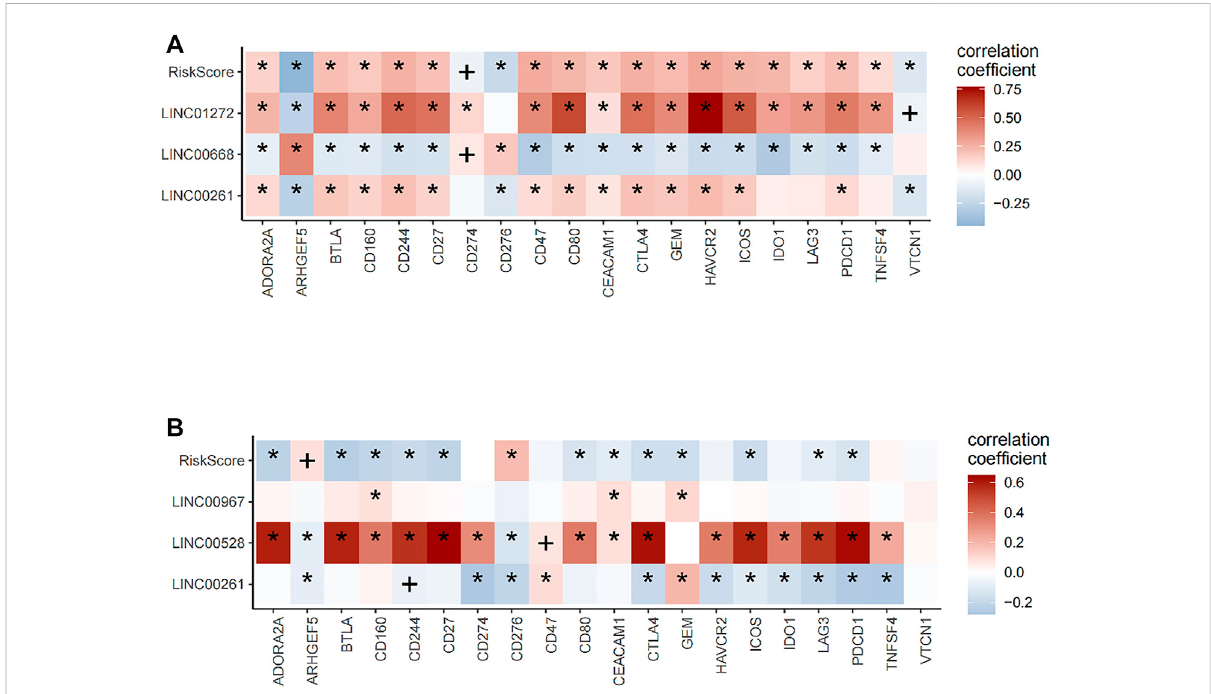
FIGURE 9 CorrelationanalysisoflncRNAandriskScorewithexpressionlevelsofimmunecheckpointblockade(ICB). (A) Inlungsquamouscellcarcinoma, risk score, LINC01272, and LINC00261 positively correlated with the expression of most ICBs, while LINC00668 had negative correlations with the expression of most ICBs. (B) In lung adenocarcinoma, risk score had a negative correlation with the expression of most ICBs, while LINC00528 positively correlated with the expression of most